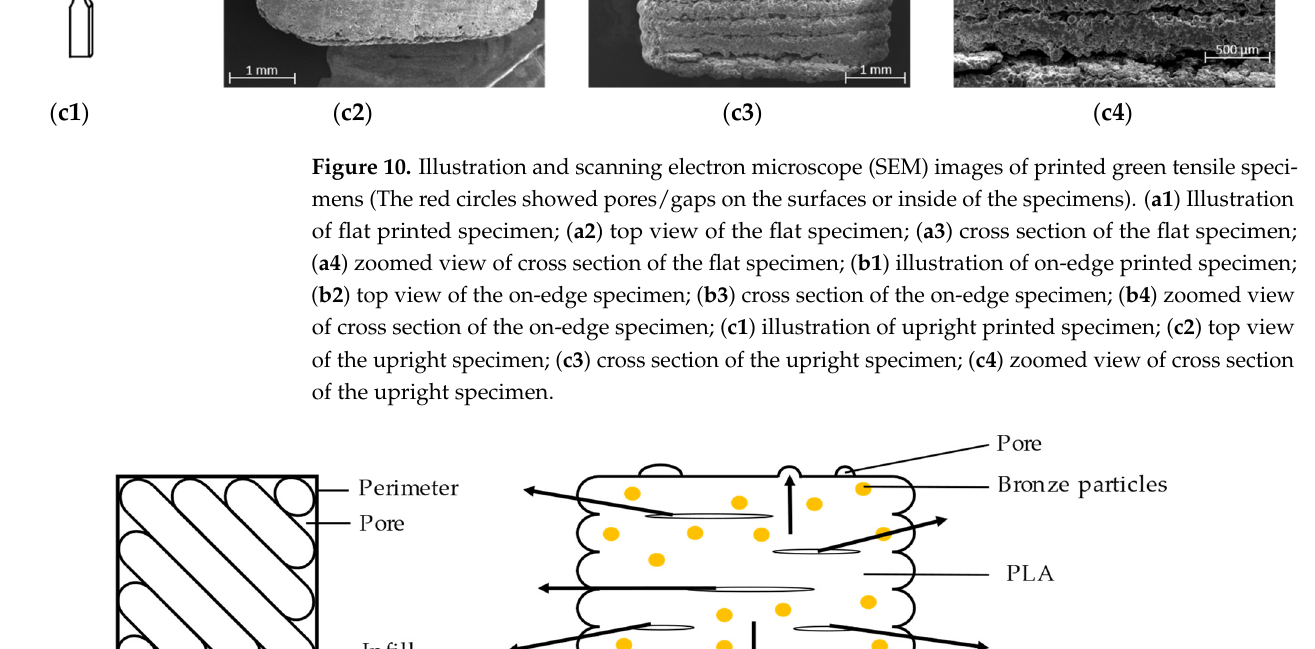
Figure 11. Diagram of PLA volatilization and pore formation during debinding: ( a ) top view of a green part; ( b ) cross section of a green part and the exit directions of gaseous PLA during debinding.